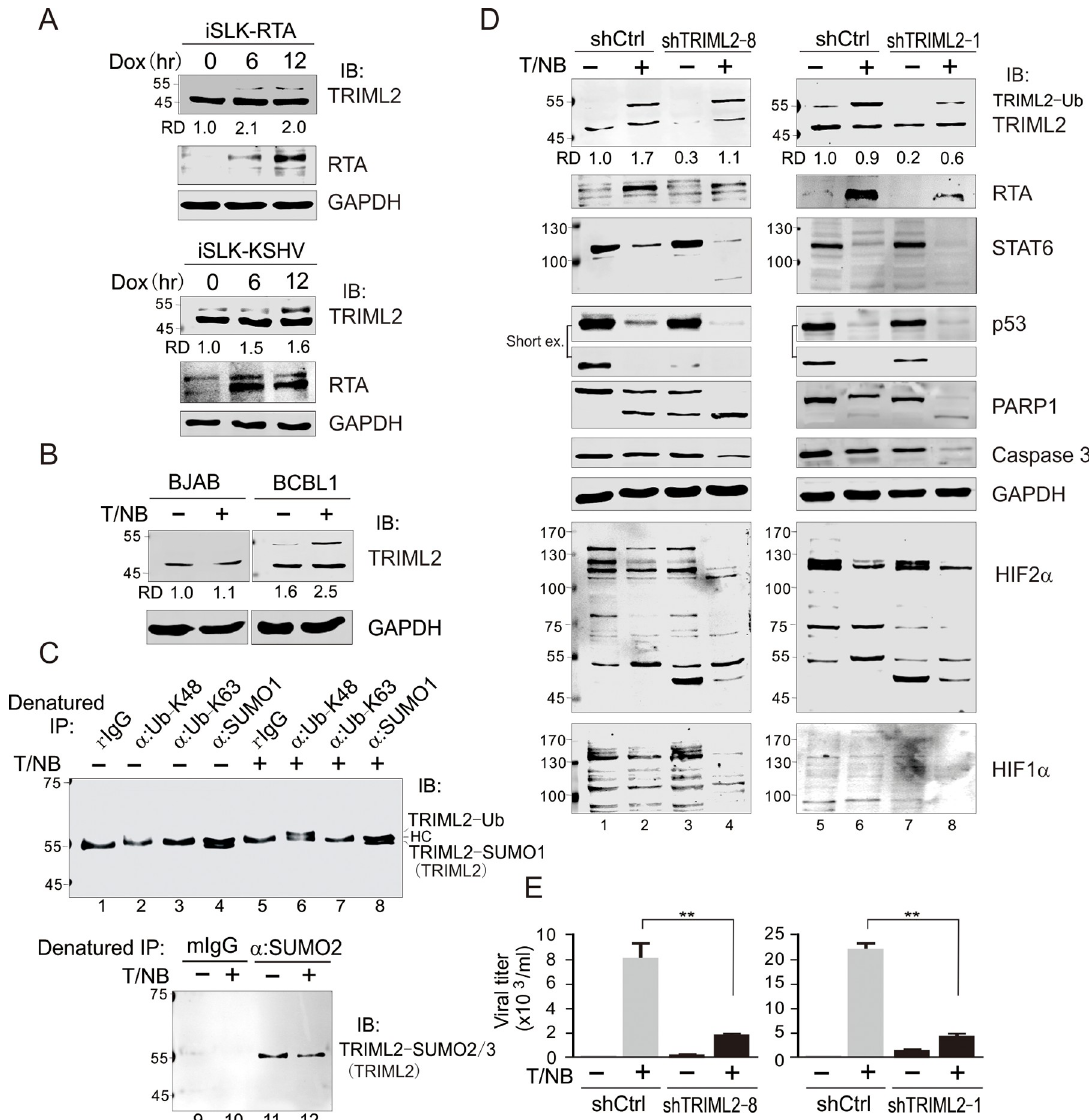
Fig 7. TRIML2 contributes to KSHV lytic replication and cellular anti-apoptosis. (A) RTA induced the expression and ubiquitylation of TRIML2. iSLK cells carrying doxycline-induced RTA (iSLK-RTA) or RTA and KSHV whole genome (iSLK-KSHV) were treated with doxycline for different time points, and subjected to immunoblotting as indicated in figure. (B) Reactivation of KSHV in PEL cells induced expression and ubiquitylation of TRIML2. KSHV-negative B lymphoma BJAB and KSHV-positive BCBL1 cells were individually treated with or without TPA/sodium butyrate (T/NB) for 24 h, and subjected to immunoblotting as indicated. (C) K48-linked ubiquitylation of TRIML2 was induced during KSHV reactivation. Whole cell lysates (WCLs) of BCBL1 described in panel B were lysed and aliquoted equally for denatured immunoprecipitation (IP) with antibodies specific against K48 or K63 polyubiquitin, SUMO1 and SUMO2/3, respectively, and immunoblotting (IB) for TRIML2. Rabbit and mouse IgG (rIgG, mIgG) were individually used as negative control. (D) Knockdown of TRIML2 reduced the expression of RTA and anti-apoptosis ability of KSHV-infected PEL cells. BCBL1 cells with TRIML2 (shTRIML2-8, or shTRIML2-1) or luciferase control (shCtrl) stable knockdown were individually treated with or without TPA/NaB (T/NB) for 24 h, and subjected to immunoblotting as indicated. (E) TRIML2 knockdown reduced TPA- and sodium butyrate-induced KSHV virion production. The supernatants from equal amounts cells in panel D were purified to quantitate virion production. The statistical significance was evaluated and p < 0.05 indicated as double asterisks.